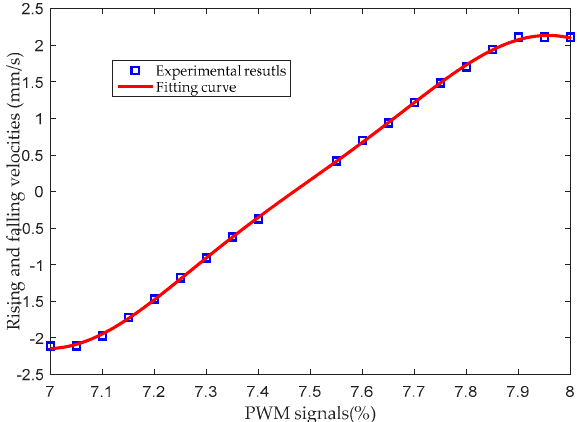
Figure 9. ( a ) The upper state of lifting and supporting wheel mechanism (LSWM); ( b ) the lower state of LSWM.